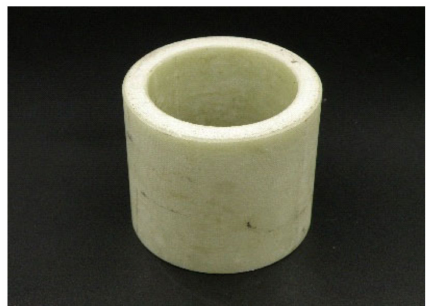
Figure 1. Textolite bushing support that came from an operated 110 kV surge arrester. Due to the lack of any degradation effects, the element was taken as a reference